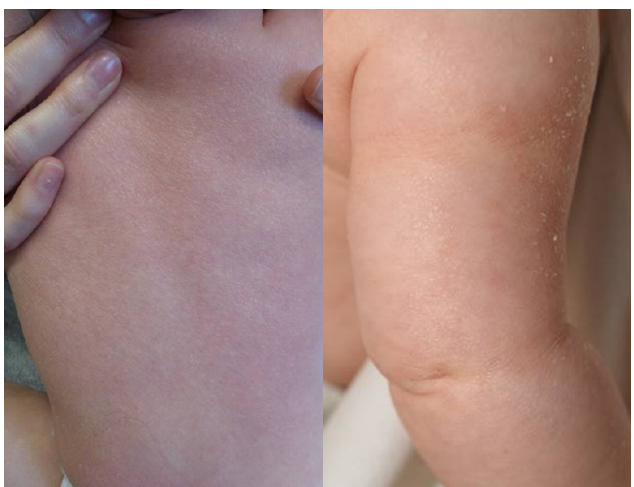
Figure 1. The affected child showed fine whitish scales and mild erythema (on the left: back; on the right: upper arm).